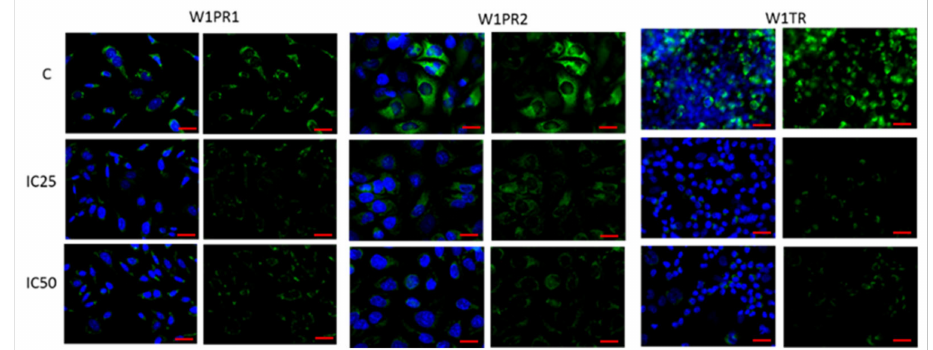
Figure 8. Immunofluorescence visualization of COL3A1 expression in PAC and TOP- resistant cell lines after piperine treatment. COL3A1 was detected using the anti-COL3A1 antibody and an Alexa Fluor ® 488-conjugated secondary antibody (green). Cell nuclei were stained with DAPI (blue). Row C shows the control state (cells without piperine), IC25 and IC50 show the cells treated with piperine for 72 h. The first column shows both DAPI (blue) and target protein signal (green), the second column shows the target protein signal alone. Scale bar = 2- µ